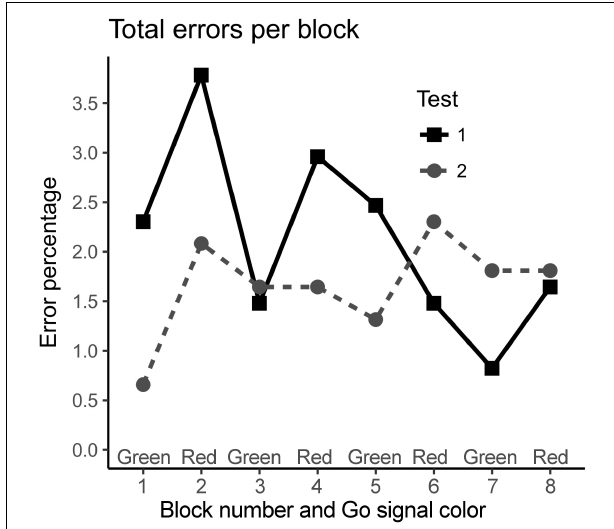
FIGURE 2 | The total error percentages of the Go trials per block in the first test (Test 1) and in the retest (Test 2). The rate of total errors decreased towards the end of the first test but within the second test the error rate remained stable.